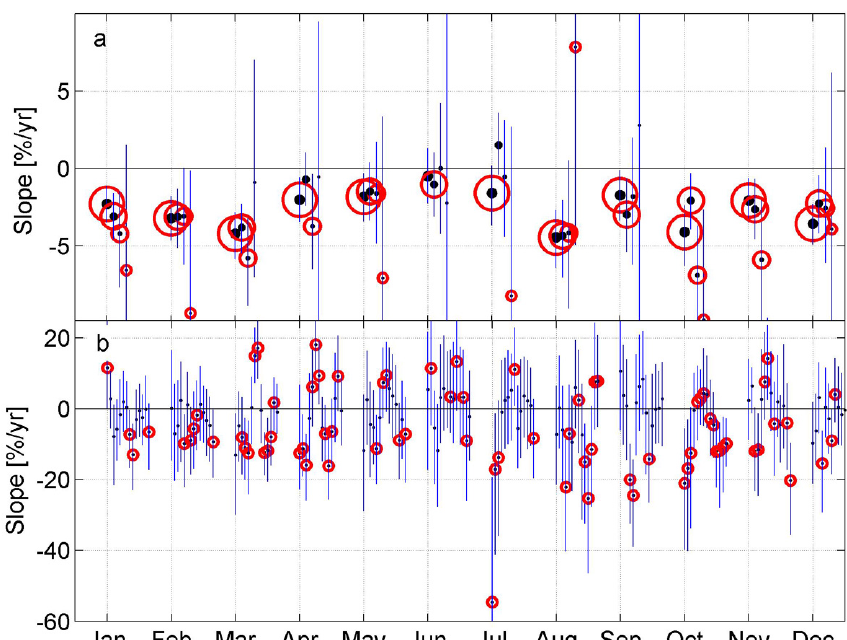
Fig. 2. Seasonal MK trend analysis of the ACA scattering coefficient: (a) trends of the entire dataset (18yr), of the last 15, 10 and 5yr, the size of the points and of the circles corresponding to the analyzed length of time, (b) MK trend analysis of all possible 5yr trends for the ACA dataset. Black points correspond to Sen’s slopes, red circles to slopes that are statistically significant at the 95% confidence levels, respectively. Blue lines correspond to the Sen’s slope 90% confidence limits.